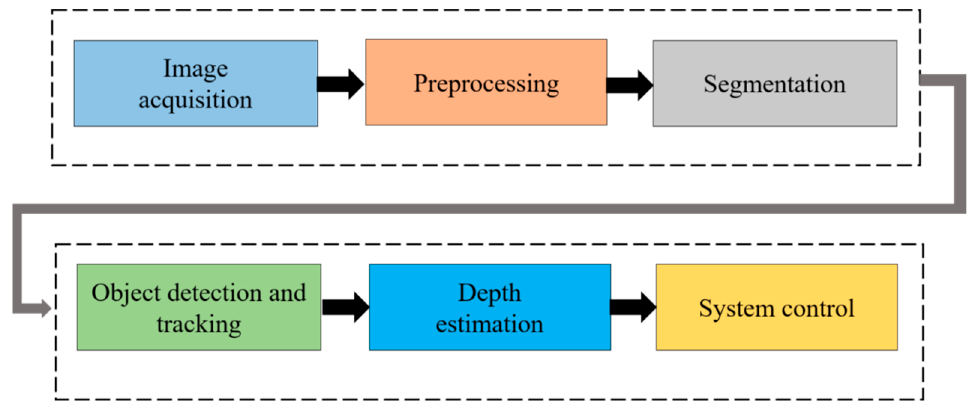
Figure 5. Vision data flow of an advanced driver assistance system (ADAS).